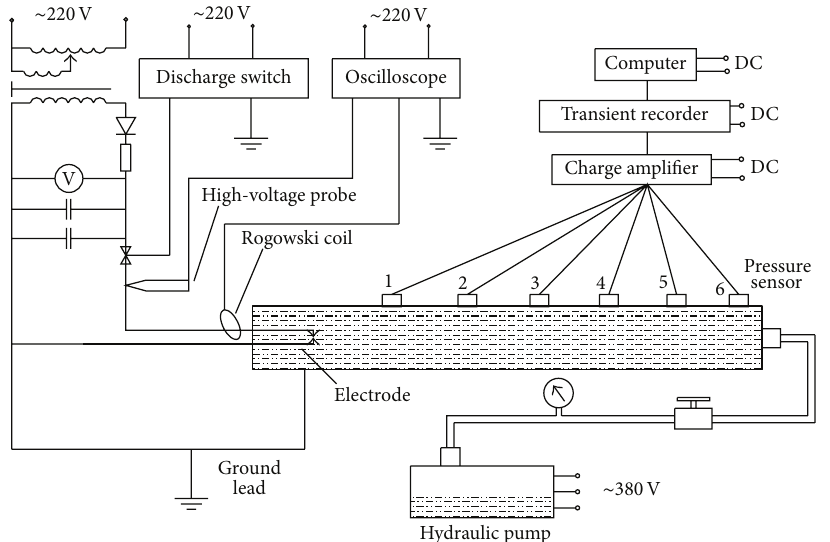
Figure 1: Schematic diagram of experimental device.